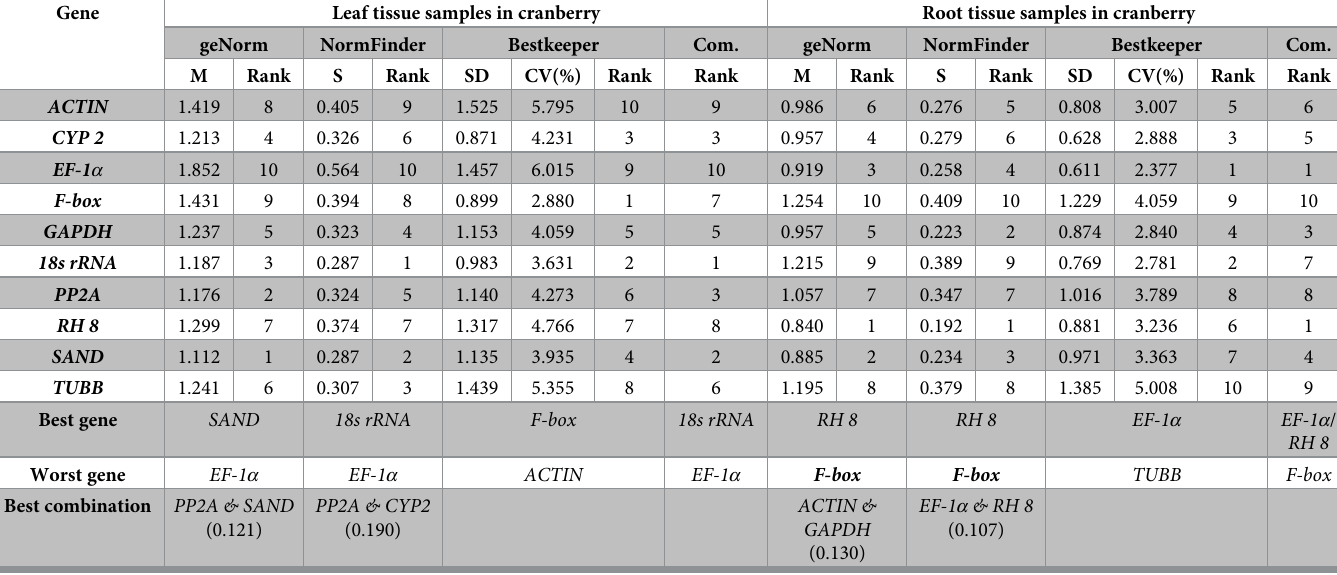
Table 5. Rankings of candidate reference 10 candidate reference genes in leaf or root tissue samples treated with three stresses, using the geNorm, NormFinder and BestKeeper algorithms. Gene